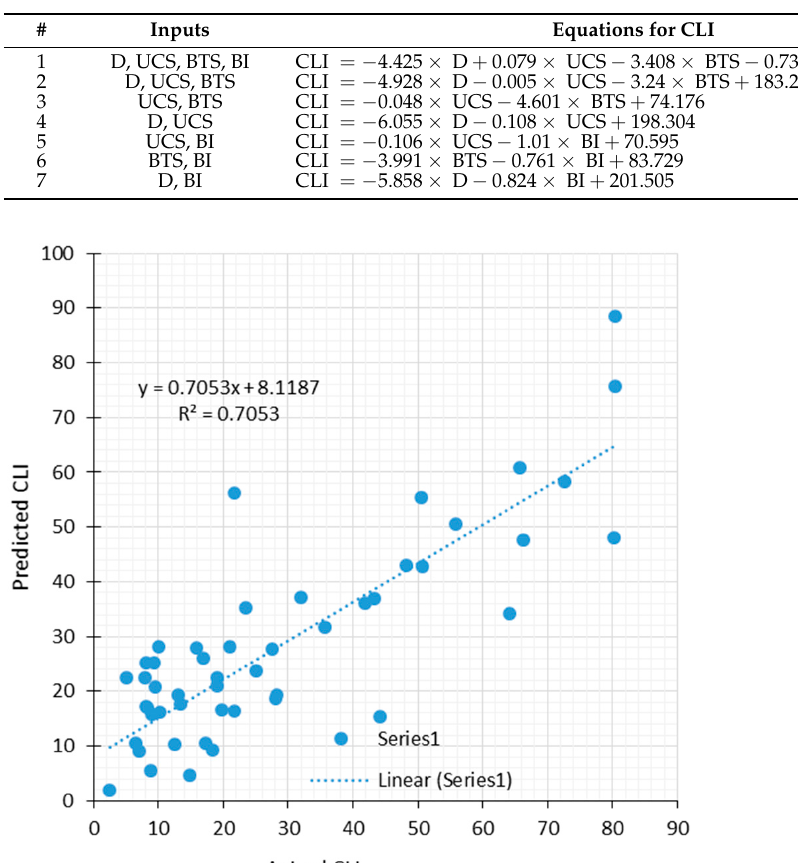
Table 7. Results of multi ‐ variable linear regression of CLI as function of other rock properties .